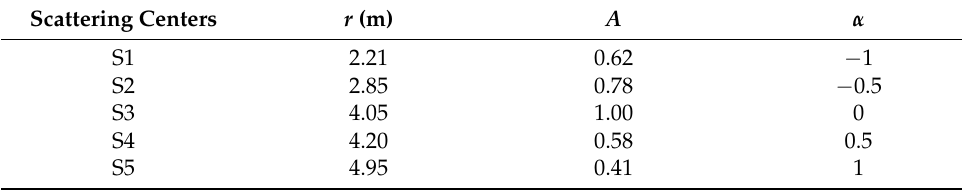
Table 1. Scattering parameters of the five SCs.